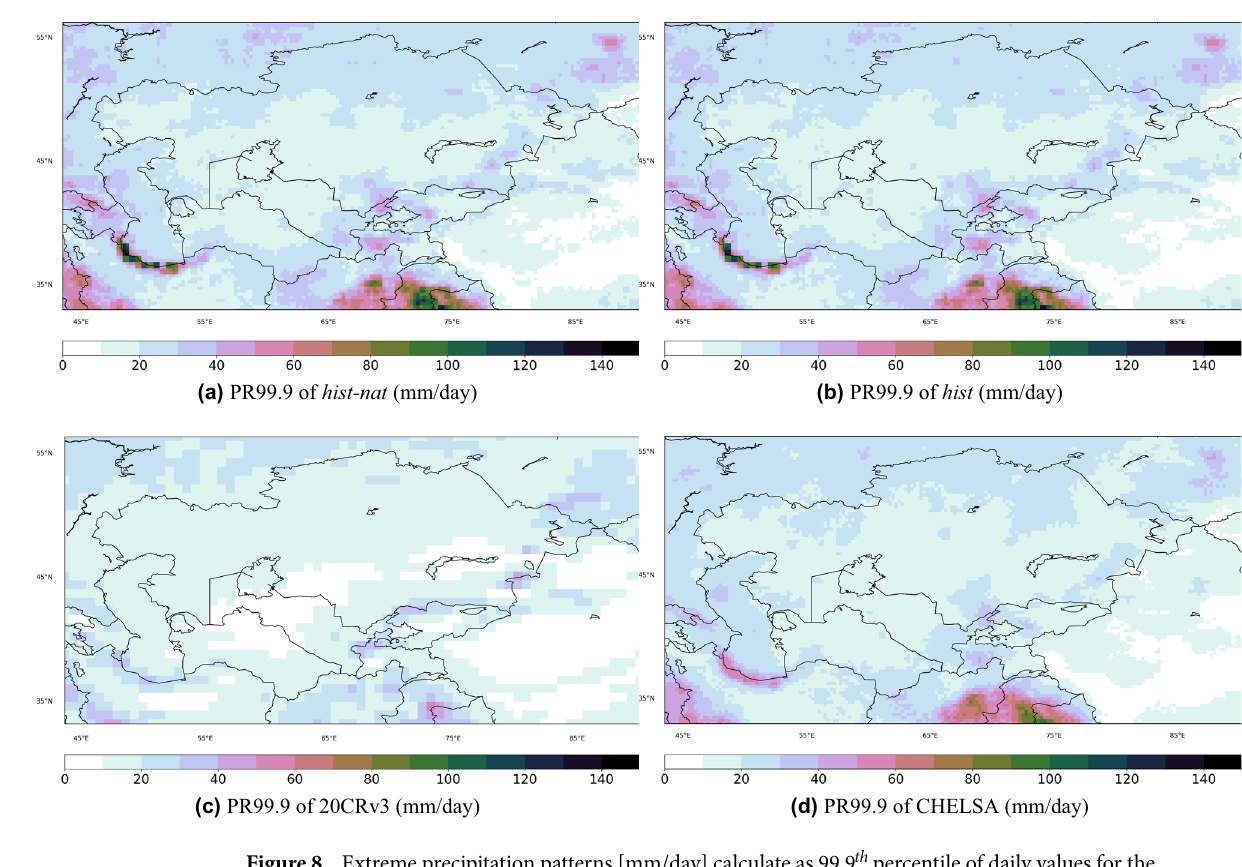
Figure 8. Extreme precipitation patterns [mm/day] calculate as 99.9 overlapping period of 1979–2014 for ( a ) CHELSA, ( b ) models’ ensemble mean of the historical run. All the ◦ datasets are at 0.25 resolution. The maps were created using python3-matplotlib (version 3.1.2, https:// matpl otlib.